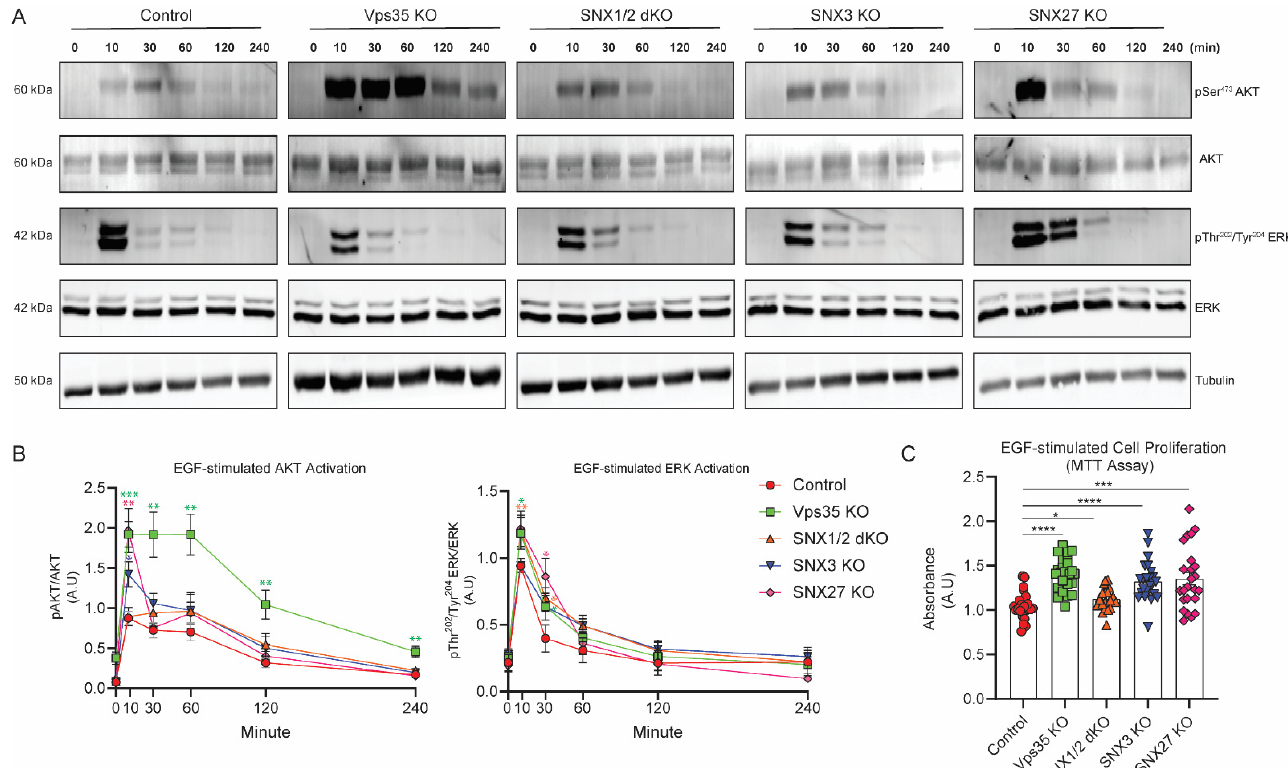
Figure 6. Retromer Vps35 and SNXs depletion altered the kinetics of EGF-stimulated EGFR signaling activation. ( A ) EGF-treated cells were lysed at various time points as indicated. Equal amounts of protein samples were subjected to immunoblotting and labelled with the antibodies against phosphor-Ser473 AKT, AKT, phosphor-Thr202/Tyr204 ERK, ERK, or tubulin. Representative images are from at least three independent experiments. ( B ) Normalizations of phosphor-Ser473 AKT to AKT or phosphor-Thr202/Tyr204 ERK to ERK are represented as the fold difference for AKT and ERK activation levels between HeLa and KO cells (means ± SEM). Two-tailed student’s t -test indicated the difference between HeLa and KO cells at the time points indicated, * p < 0.05; ** p < 0.01; *** p < 0.001. ( C ) HeLa control and KO cells were either cultured in serum-free DMEM medium or serum-free DMEM medium containing 100 ng/mL of EGF for 24 h before being subjected to MTT assay. Optical absorbance was measured under 590 nm wavelength using a microplate reader, and the